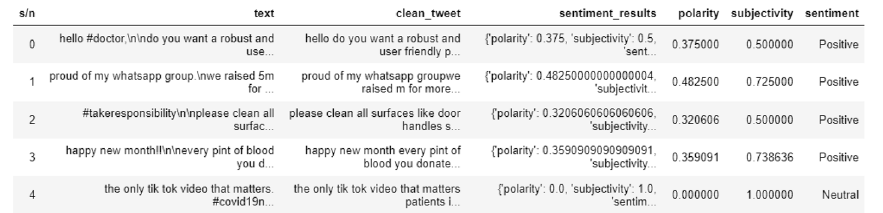
Fig. 5 Diagram showing category distribution of sentimental analysis using TextBlob